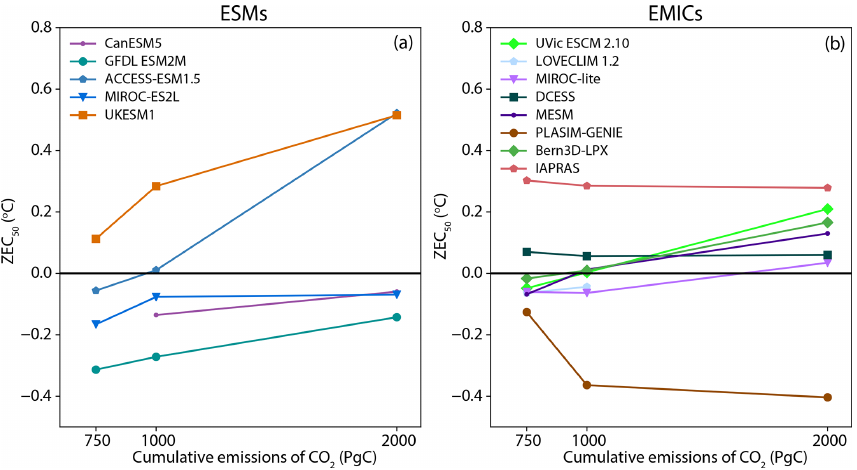
Figure 6. Values of ZEC 50 for the 750, 1000, and 2000PgC experiments branching from the 1% experiment (type A). Panel (a) shows results for full ESMs, and panel (b) shows results for